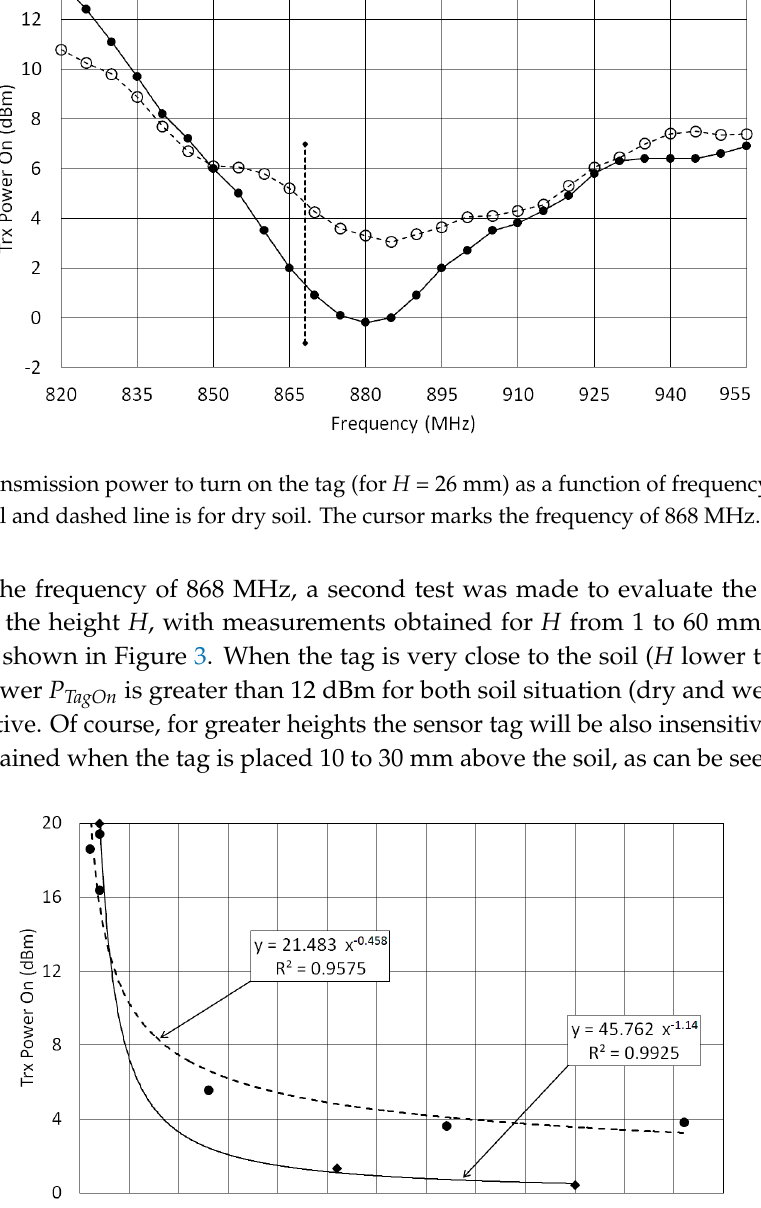
Figure 3. Transmission power to turn on the tag (for 868 MHz) as a function of the distance between tag and soil ( H ). Diamonds (solid line) are for wet soil and dots (dashed line) are for dry soil. Using the results of Figure 3, a system with two conventional UHF RFID tags (adhesive labels) was designed. The sensor tag was fixed with H = 12 mm and a second tag (the reference one) was placed with A = 100 mm, where the tag was assumed to be insensitive to soil moisture. A photo in material. The reading distances ( R ) of 30, 60 and 90 cm were used to measure the transmission power P TagOn for sensor and reference tags over dry and wet soils, as seen in Figure 5.